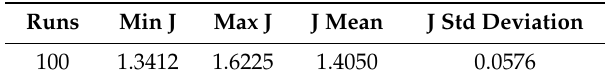
Table 3. Results of the Monte-Carlo analysis: number of runs, minimum, maximum and mean values of the residual cost function J and standard deviation.